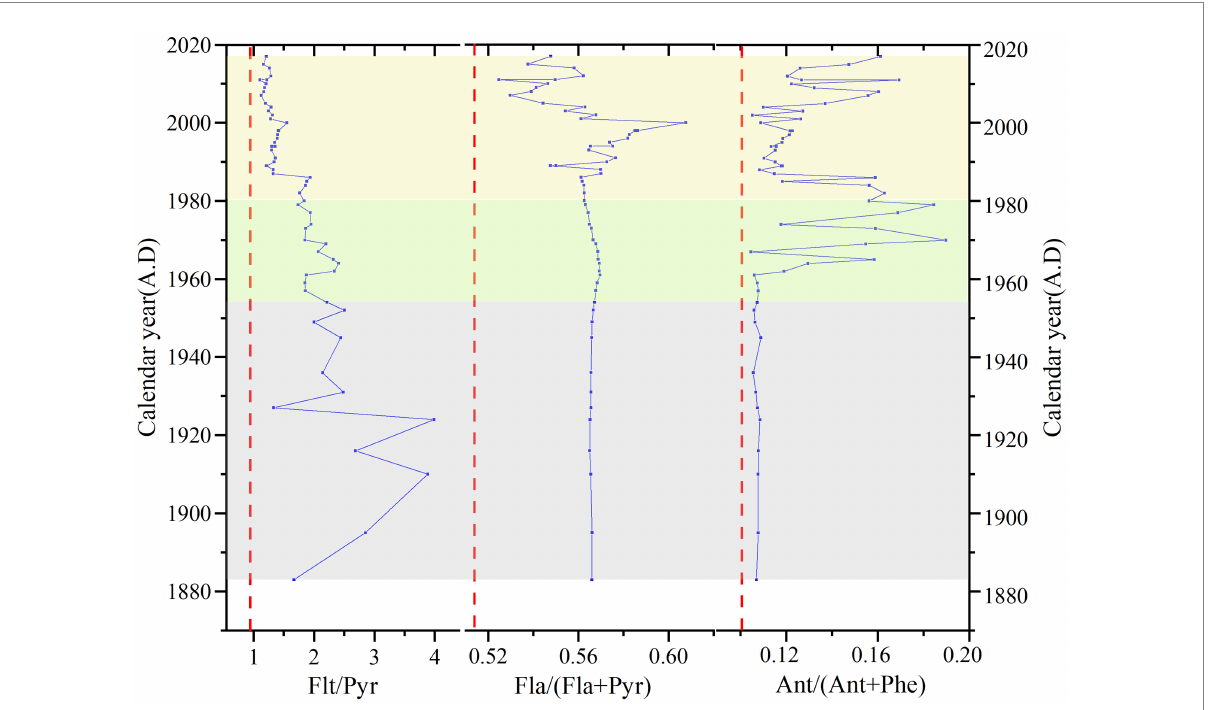
FIGURE 6 Variation of ratios of Flt/Pyr, Fla/(Fla + Pyr), and Ant/(Ant + Phe) in JDY peat core. The dashed lines indicated the boundaries for source assignments of PAHs after (Yunker et al., 2002).